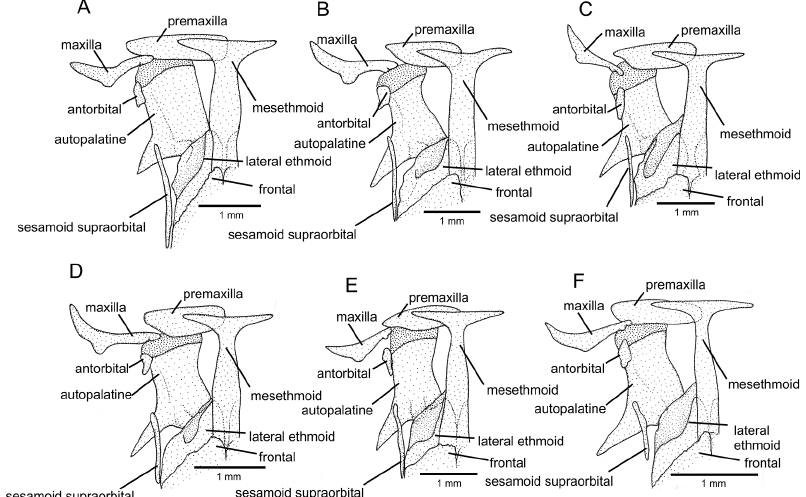
Figure 5. Mesethmoidal region, with middle and left portions, and in dorsal view: ( A ) Trichomycterus (Cryptocambeva) garbei Costa, Azevedo-Santos & Ka tz sp. nov.; ( B ) Trichomycterus (Cryptocambeva) listruroides Costa, Ka tz & Azevedo-Santos sp. nov.; ( C ) Trichomycterus (Cryptocambeva) saturatus Costa, Ka tz & Azevedo-Santos sp. nov.; ( D ) Trichomycterus (Cryptocambeva) uberabensis Costa, Azevedo-Santos & Ka tz sp. nov.; ( E ) Trichomycterus (Paracambeva) adautoleitei Costa, Ka tz & Azevedo-Santos sp. nov.; and ( F ) Trichomycterus (Paracambeva) coelhorum Costa, Azevedo-Santos & Ka tz sp. nov. Larger stippling represents cartilage.